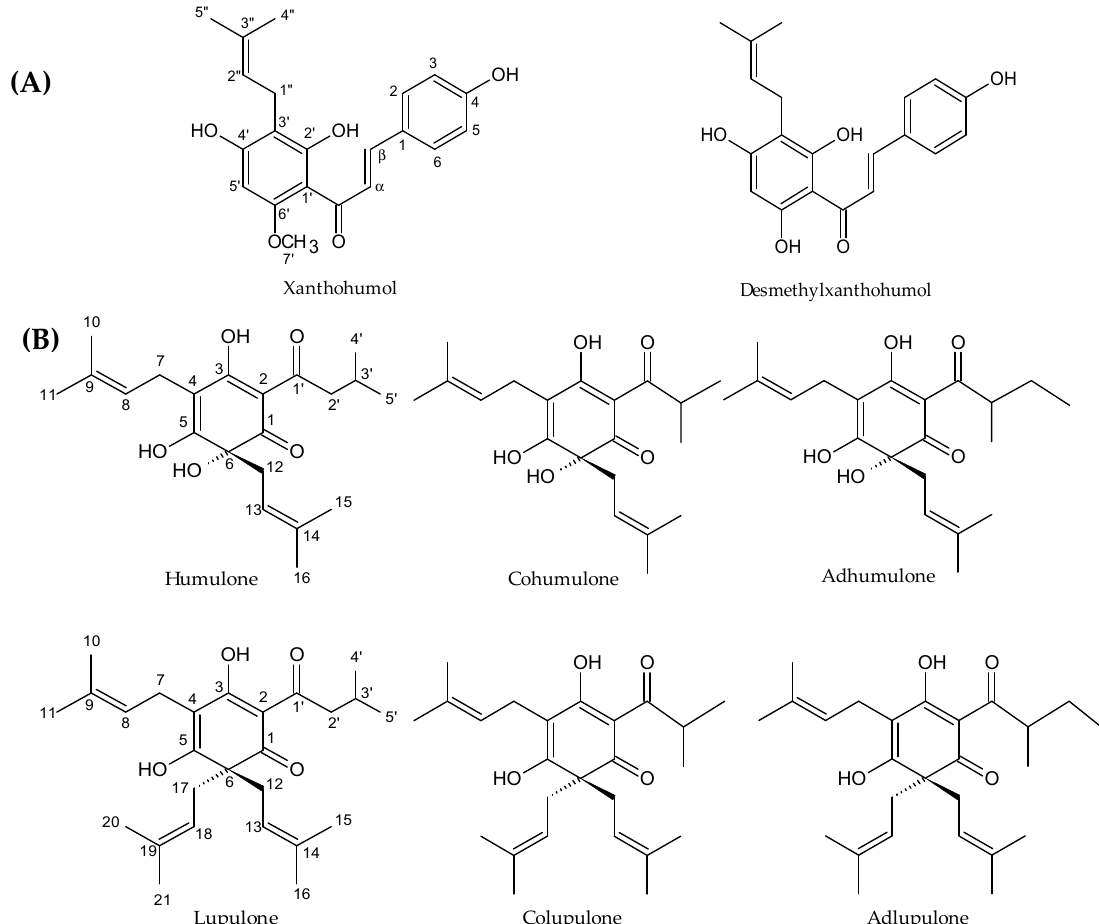
Figure 1. Structures of the main prenylated phenolic compounds from hops. ( A ) prenylated chalcones ( B ) acylphloroglucinol derivatives.